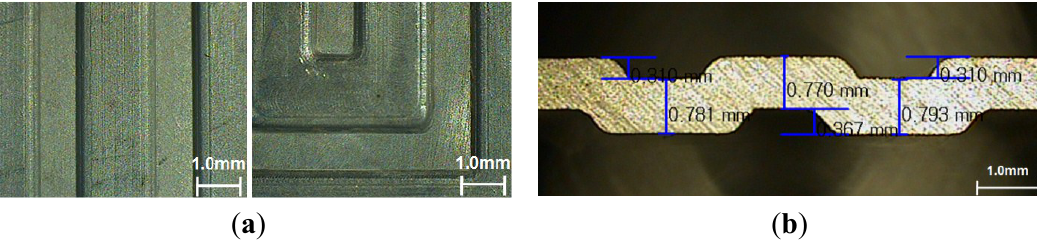
Figure 11. Surface and cross section in Maze 4 of a sample fabricated with a pouring temperature of 730 °C, plunger speed of 3.0 m/s, and vacuum pressure of 250 mbar (40× magnification). ( a ) Surface; ( b ) Cross